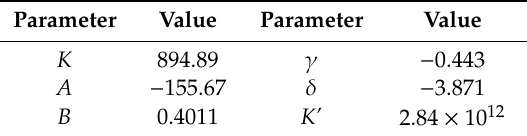
Table 3. Fitted parameters of the induction